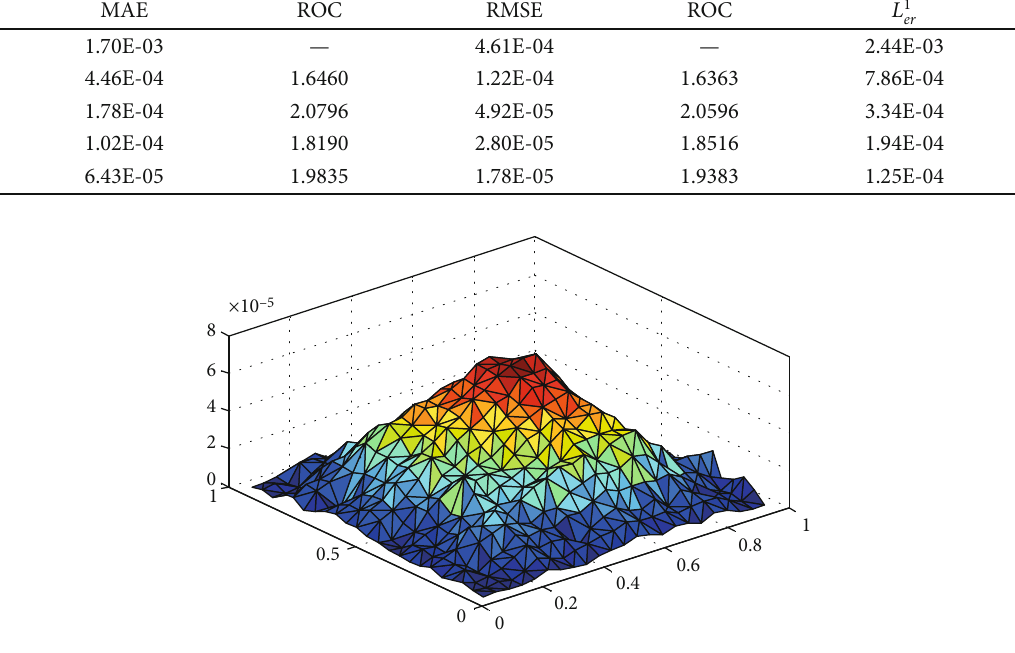
Figure 10: Absolute errors with N Table 13: Errors for Example 5 using two di ff erent values of N